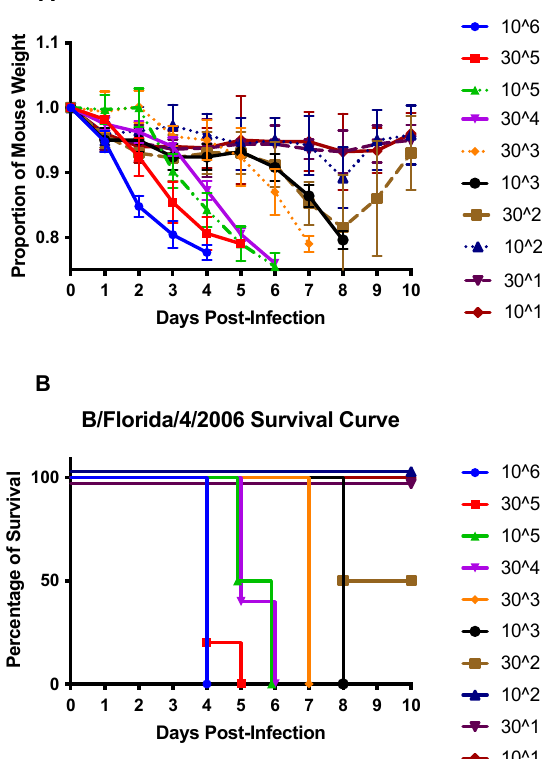
Figure 1. Weight loss ( A ) and survival ( B ) of B/Florida/04/2006-challenged C57BL/6 (B6) mice. B6 mice were i.n. infected with 10 6 or half-log dilutions down to 10 1 PFU of B/Florida/04/2006. Weight loss and survival were recorded daily for ten days post-infection. Points represent the mean +/ − SEM of the proportion of original weight (n = 5 mice/group).